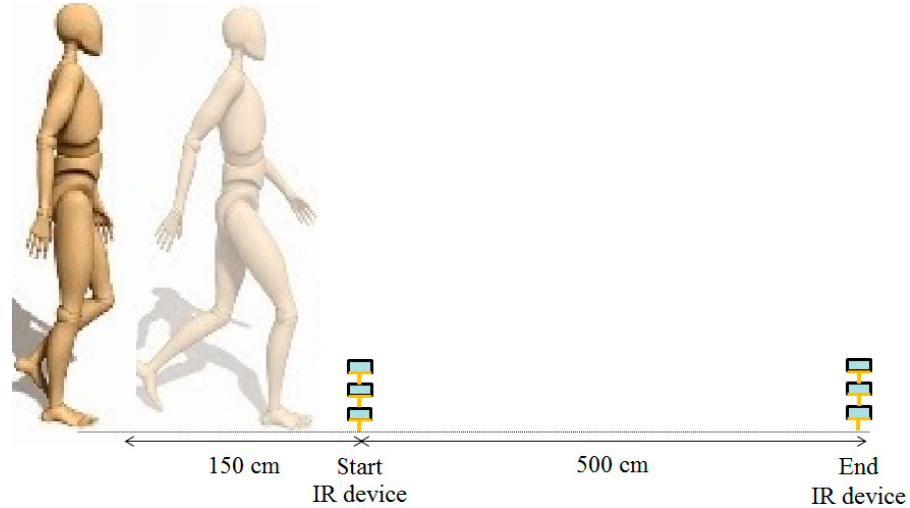
Figure 2. Infrared (IR) devices are placed at each end of a 5-m walk path to concurrently collect trunk accelerometric data when a participant passes the IR units between the start line and the end line. Participants are allowed 1.5 m for gait initiation and termination.